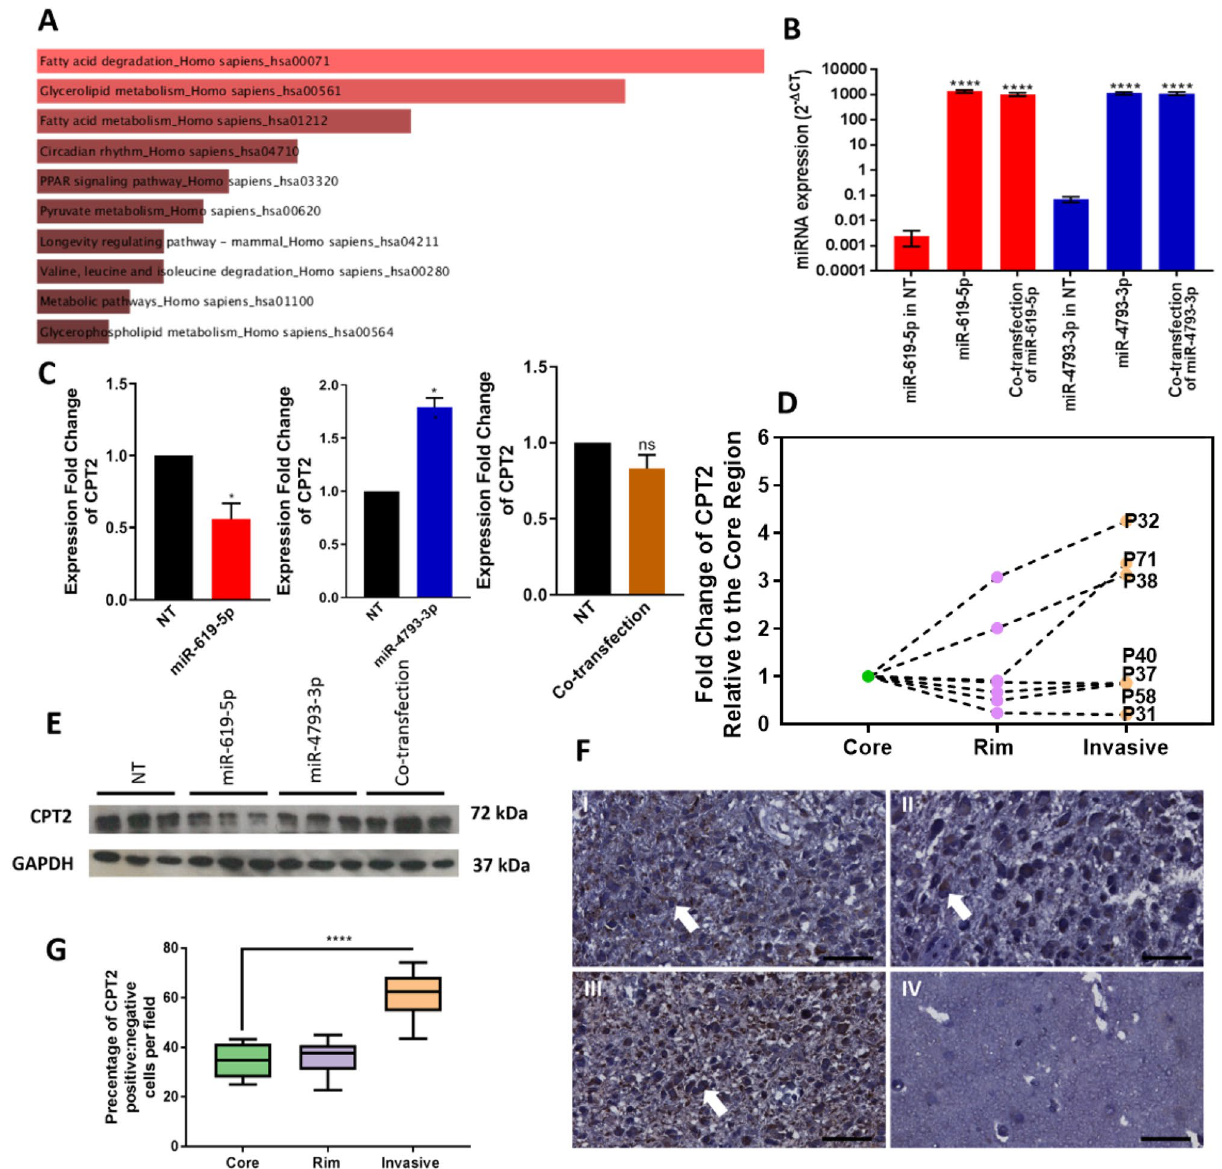
Figure 3. CPT2 as a putative target for miR-619-5p and miR-47933-3p. ( A ) Graphical representation of significantly enriched pathways for miR-619-5p and miR-4793-3p predicted gene targets. Colour shades from pink to black denotes declining levels of statistical significance. Significance was determined by two-sided sided z-score test (α < 0.05 following FDR correction). ( B ) Efficiency of miRNA knock-in transfection. qRT-PCR expression level (mean of three biological repeats ± S.E.M) of miR-619-5p (red bars) and miR-4793-3p (blue bars) in U87 cells after 24 h of transfection with either: non-targeting negative control (NT), miR-619-5p mimic (miR-619-5p), miR-4793-3p mimic (miR-4793-3p) or co-transfection with both miR-619-5p and miR-4793-3p at 1:1 ratio where 50 nM of each miRNA was simultaneously transfected. (****) p-value < 0.0001; one-way ANOVA followed by Bonferroni’s multiple-comparison test. ( C ) CPT2 expression following miRNA overexpression. CPT2 expression values in U87 cells 48 h after the overexpression of miR-619-5p (red bar), miR-4793-3p (blue bar) or both miR-619-5p and miR-4793-3p at 1:1 ratio (brown bar) are represented as fold change (mean of three biological repeats ± S.E.M) relative to CPT2 expression in NT transfected cells. (*) p-value < 0.05; (ns) non-significant; two-sided t-test. ( D ) CPT2 expression in different regions of the GBM tumour. CPT2 expression is represented as fold change relative to its expression in the corresponding core region. Data is shown for individual patients (P32, P85, and P71). ( E ) Immunoblot of CPT2 in U87 cells. Full-length blots are included in the “Supplementary Information S1” file (Supplementary Fig. 3). All samples were loaded side-by-side on the same gel and the image of the blot was cropped around the bands that correspond to the protein of interest. CPT2 expression in U87 cells (n = 3) was evaluated after 72 h of transfection. GAPDH was used as a loading control. ( F ) Immunohistochemical staining of CPT2 in GBM tumours. Immunohistochemical staining of adult GBM tissue microarrays (TMA; n = 15) with anti-CPT2 antibodies (1:200 dilution) are shown as representative images of each region; tumour (I) core (II) rim (III) invasive margin and a (IV) normal brain control sample. Images were captured at ×40 magnification; scale bars correspond to 50 μm; arrows indicated positive staining. ( G ) The Number of cells containing CPT2-positive cytoplasmic staining represented as a percentage of the total number of cells counted on each high-powered microscope fields of view. Each region was compared to the core. (****) p-value < 0.0001; one-way ANOVA followed by Bonferroni’s multiple-comparison